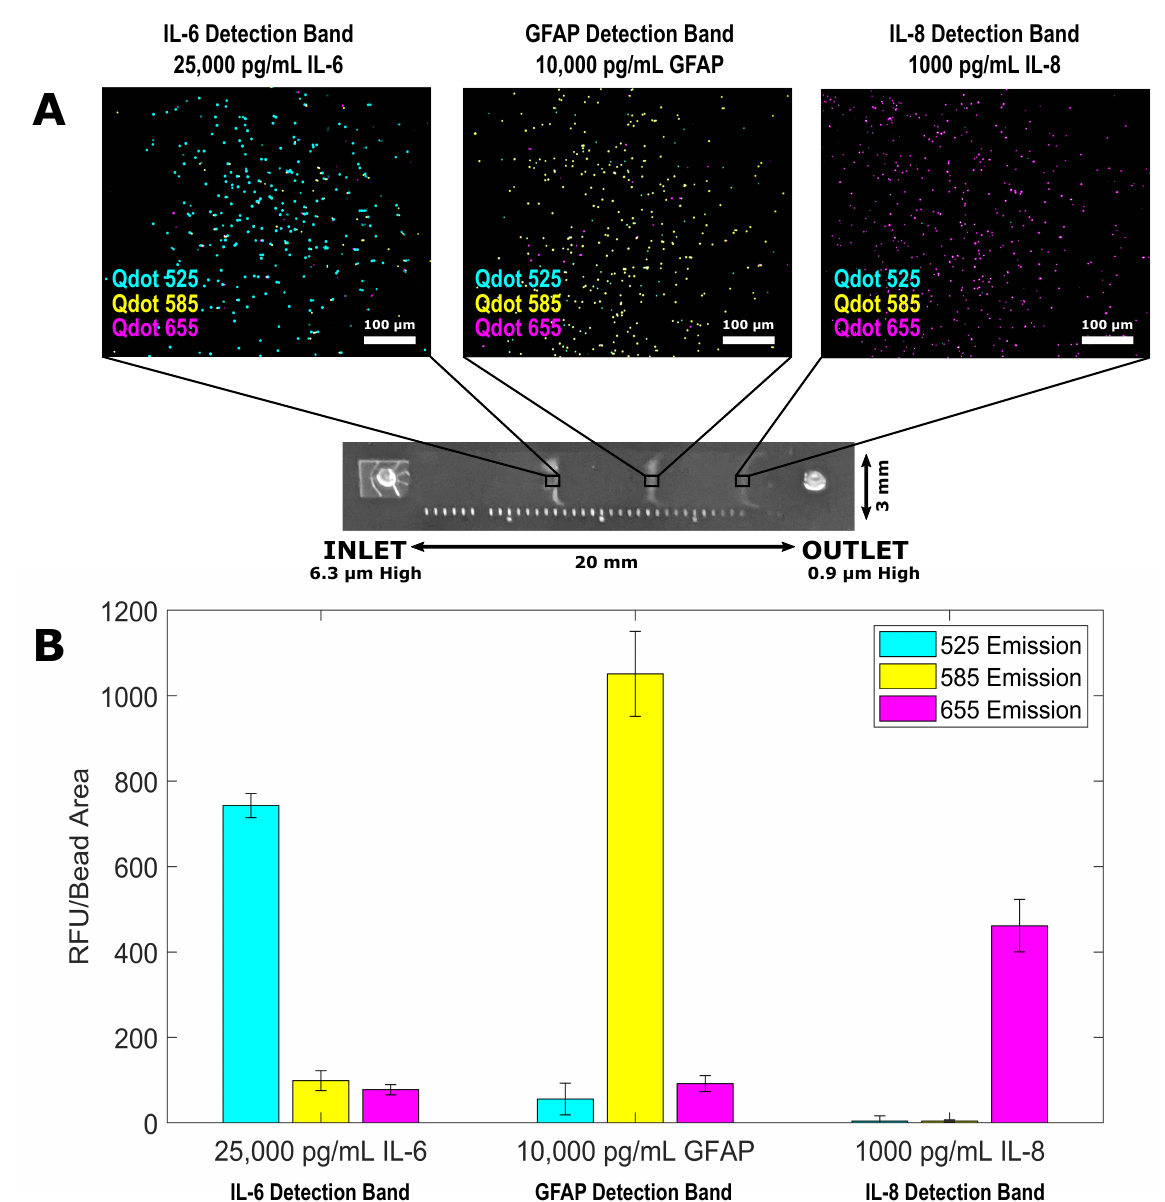
Figure 4. Multiplex of the IL-6 QLISA (fluorescent signal from Qdot TM 525), the GFAP QLISA (fluorescent signal from Qdot TM 585), and the IL-8 QLISA (fluorescent signal from Qdot TM 655) where the sample consisted of 25,000 pg/mL IL-6, 10,000 pg/mL GFAP, and 1000 pg/mL IL-8. ( A ) Representative images of ~4.5 µ m beads trapped in the IL-6 detection band of the variable height device (left), ~2.8 µ m beads trapped in the GFAP detection band (center), and ~1 µ m beads trapped in the IL-8 detection band (right). Each image is an overlay of the Qdot TM 525, Qdot TM 585, and Qdot TM 655 channels. The brightness/contrast of each image was set for ease of viewing. ( B ) The fluorescence intensity values from the Qdot TM 525 (blue), Qdot TM 585 (yellow), and Qdot TM 655 (magenta) channels for each variable height device detection band shown in ( A ) with the control values subtracted. The error bars are standard error of the mean and represent the variability in fluorescence intensity between the fields of view within each detection